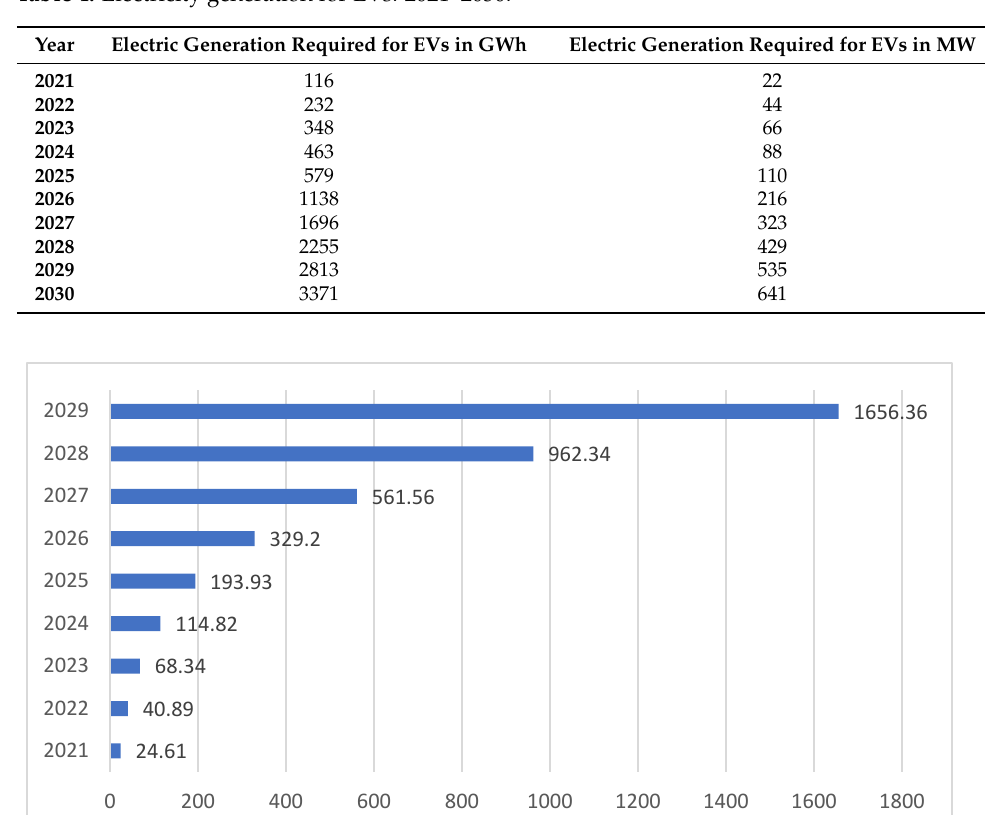
Table 4. Electricity generation for EVs: 2021 – 2030.